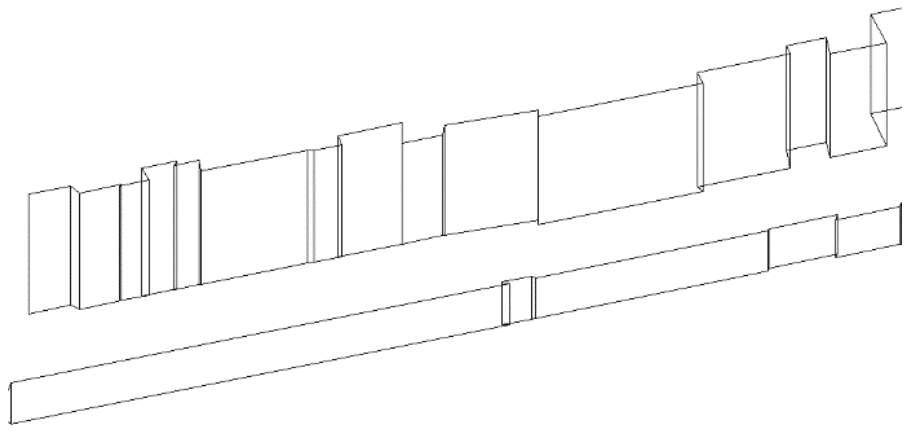
Figure 15. Spatial façade of the building beside pedestrian street in the experiment district.